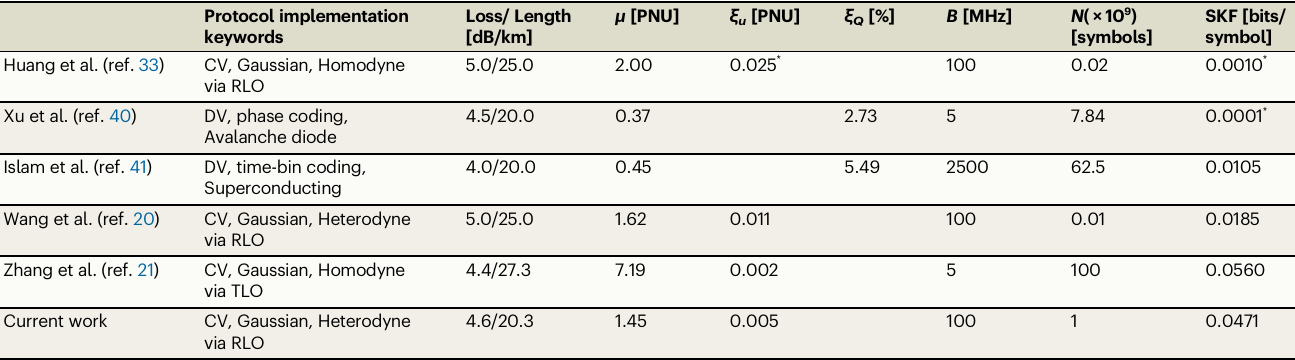
Table 1 | Comparison of notable parameters from prepare-and-measure QKD experiments conducted in the last decade with similar physical channels, as indicated by the column showing loss and length Protocol implementation